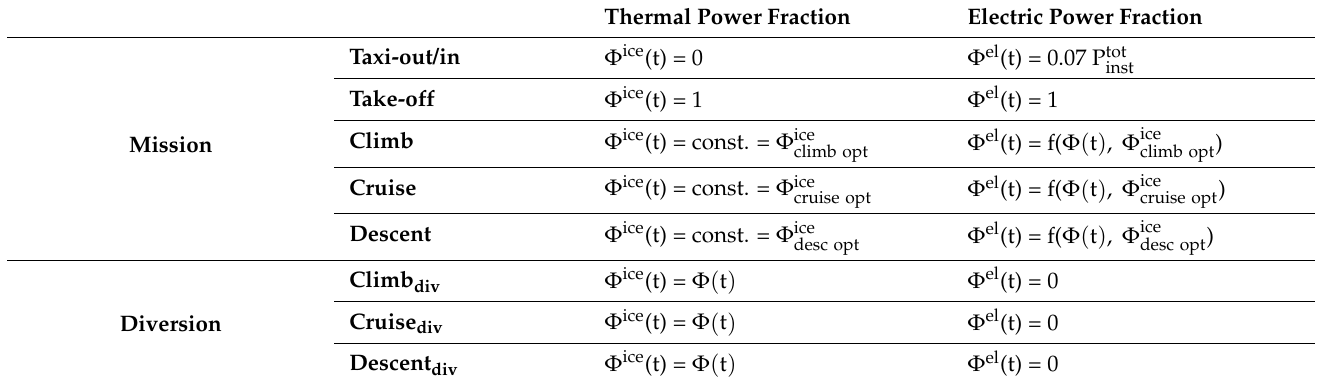
Table 3. Designer assumptions on supplied power fractions. Thermal Power